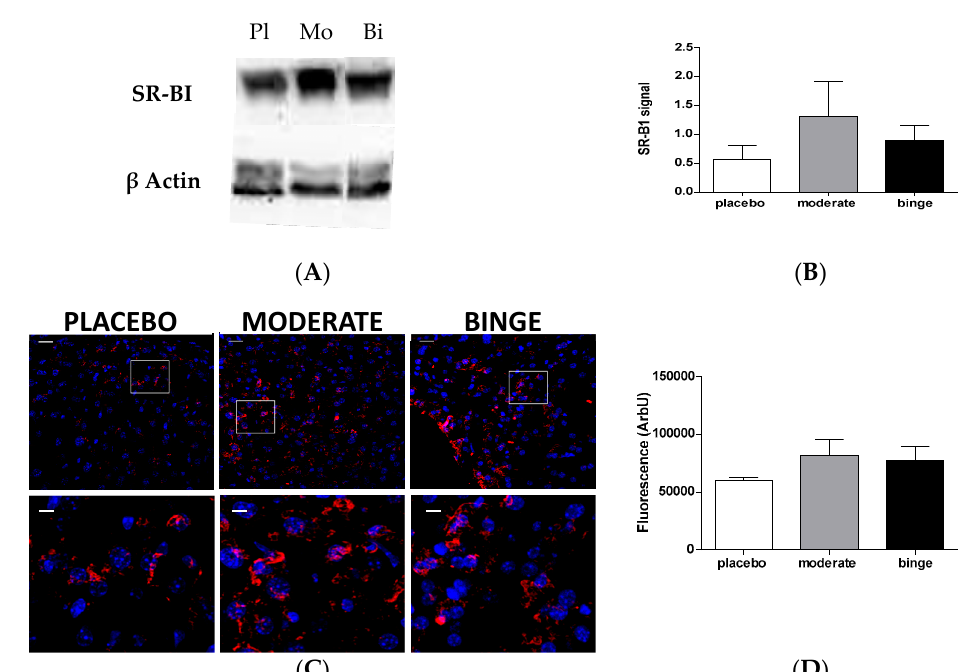
Figure 6. Effect of moderate and binge alcohol consumption on hepatic SR-BI protein expression. Western blotting analysis was performed on hepatic lysates, as described in the Methods Section. ( A ) Representative image of SR-BI expression in placebo (Pl), moderate (Mo), and binge (Bi) groups. ( B ) Signal quantification of SR-BI expression measured by ImageJ software. Signal quantification results were expressed as the ratio between SR-BI and the correspondent actin signal and data are expressed as mean ± SD ( n = 3–4 per group). Results were analyzed using one-way ANOVA followed by Tukey’s multiple comparison test among groups. ( C ) Analysis of hepatic SR-BI expression (red signal) in placebo, moderate, and binge groups. Upper panels represent 20 × magnification (thick = 25 µ m); in lower panels, areas in the squares are enlarged (thick = 6 µ m). ( D ) Results of red signal quantification were expressed as mean ± SD, after two independent analyses. Results were analyzed using one-way ANOVA followed by Tukey’s multiple comparison test among groups.